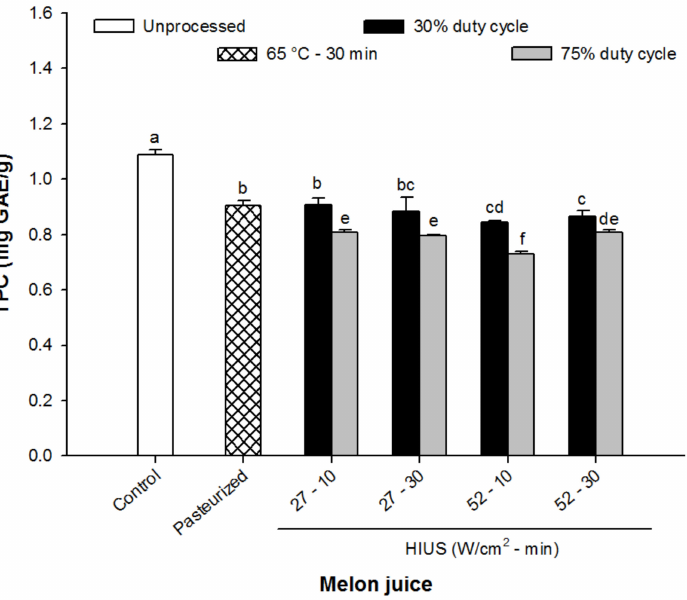
Figure 4. The total phenolic compound of control (unprocessed), pasteurized and HIUS processed melon ( Cucumis melo ) juice. Different letters above the bars indicate statistical difference in treatments ( p < 0.05) ( n =